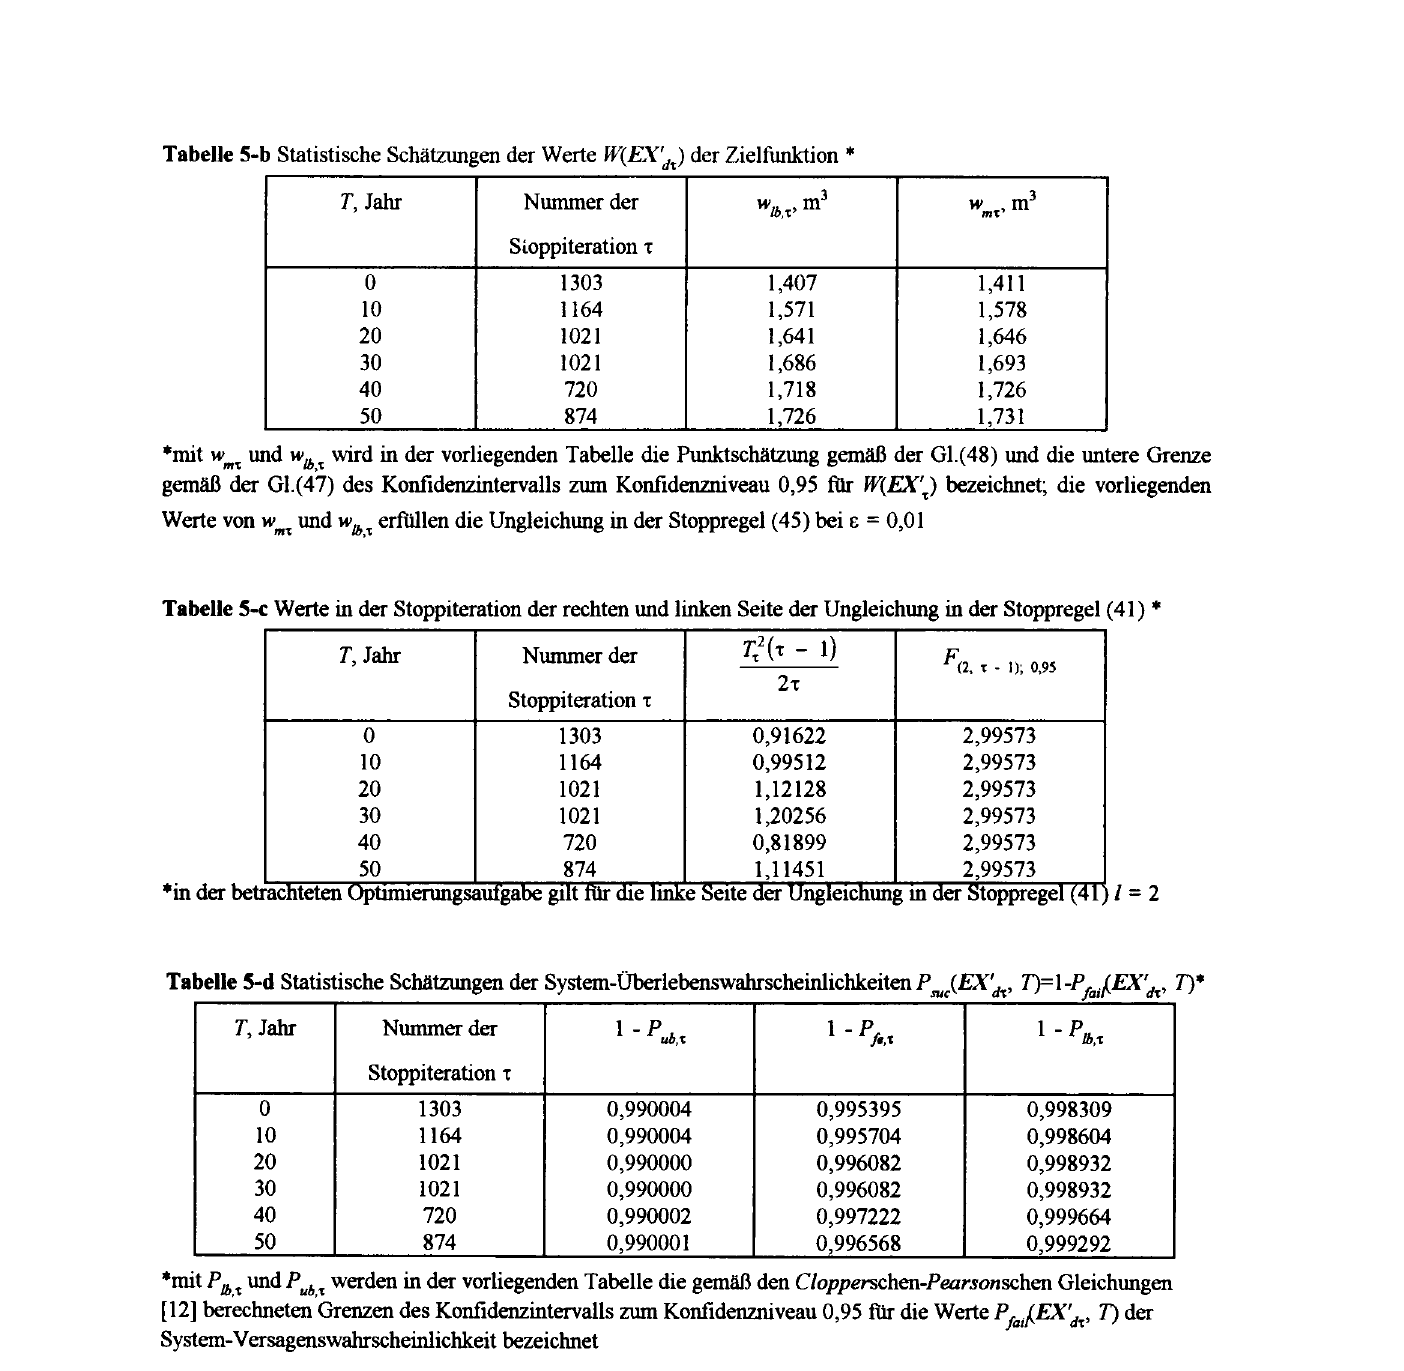
*mit P lh,t Wld Pub,t werden in der vorliegenden Tabelle die gemaB den Clopperschen-Pearsonschen GleichWlgen [12] berechneten Grenzen des Konfidenzintervalls zwn Konfidenzniveau 0,95 ftlr die Werte Pfai~EX'd•' T) der System-V ersagenswahrscheinlichkeit bezeichnet